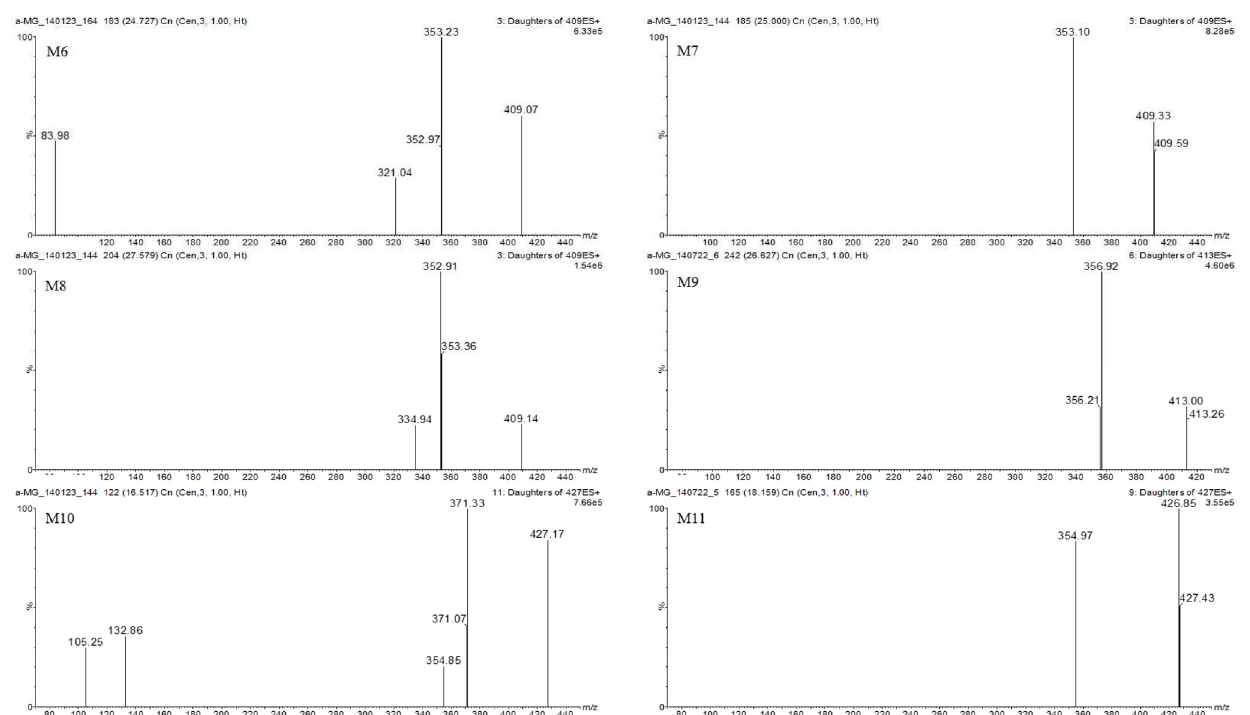
Fig 5. Spectrums of tentative metabolites (M6 – M11) detected in mice ’ s plasma, urine, feces, liver and small intestine after intravenous and oral administration of α -MG and S9 fractions of the liver and small intestine after 30 min incubation.